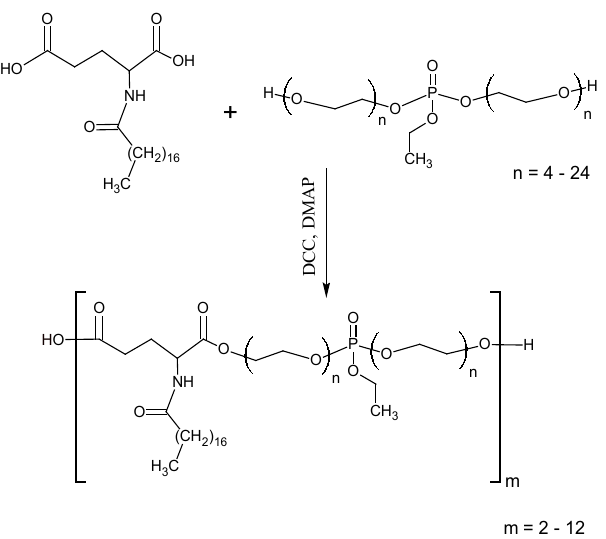
Figure 1. Synthesis of phosphorus- containing polyesters (PPE) with an ethyl phosphate group.